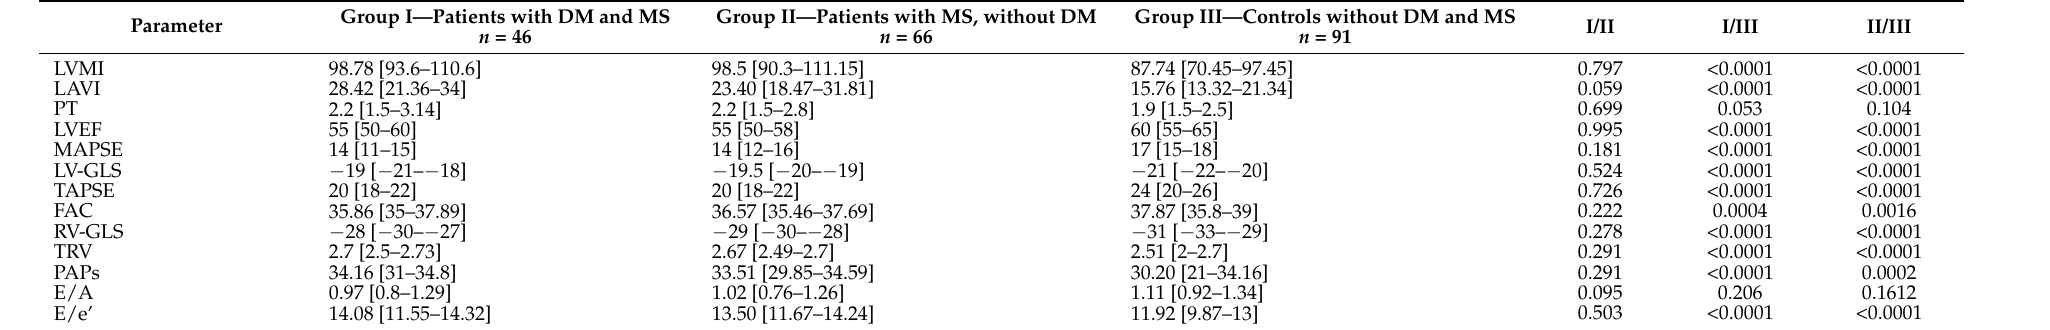
Table 3. Patient echocardiographic